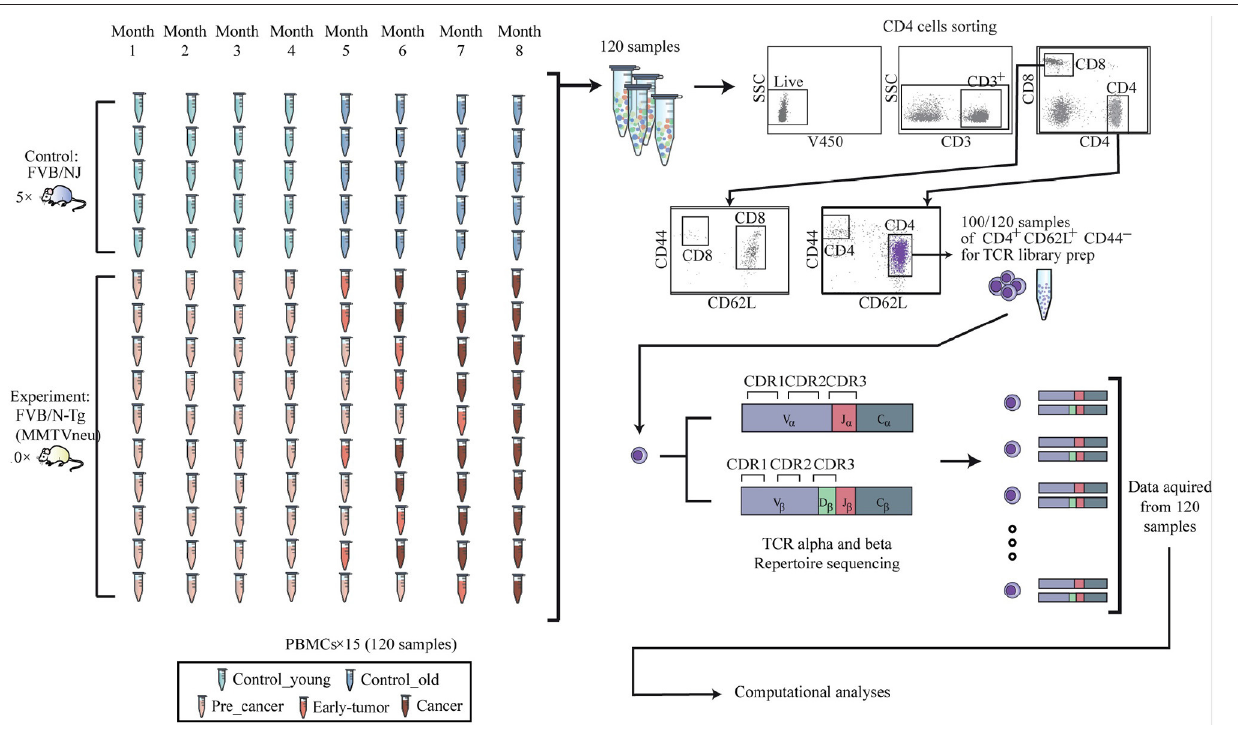
FIGURE 1 | Experimental procedure 120 blood samples were drawn from the retro-orbital sinus of 10 FVB/N-Tg (MMTVneu), a mouse model of HER2 human breast cancer mice, and from 5 FVB/NJ control mice. Over these 8 time points, none of the control mice (blue) developed any tumors. Progress of tumor in the ten transgenic mice is demonstrated using the red colored samples in the figure. The last time point before tumors are shown was defined as pre-cancer and marked light red. From each time point, the peripheral blood mononuclear cells were isolated and stained for flow cytometry. Cells were analyzed and gated for sorting using a FACS ARIA III sorter, and CD4+CD62L+CD44- naive population was separated for RNA extraction and T cell receptor library preparation.